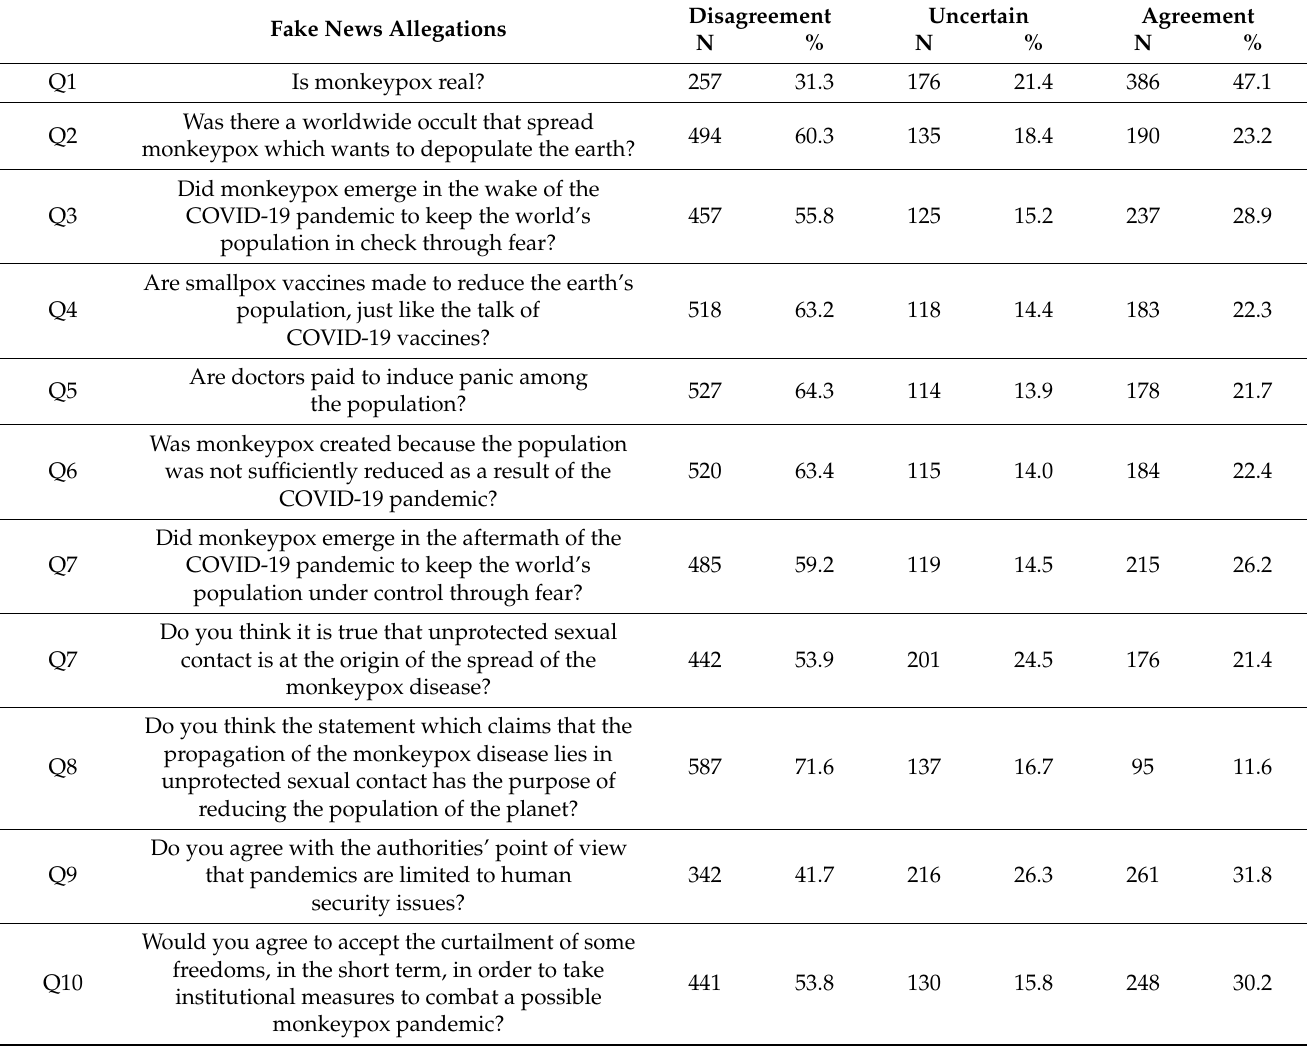
Table 8. Rating of “fake news” statements by survey